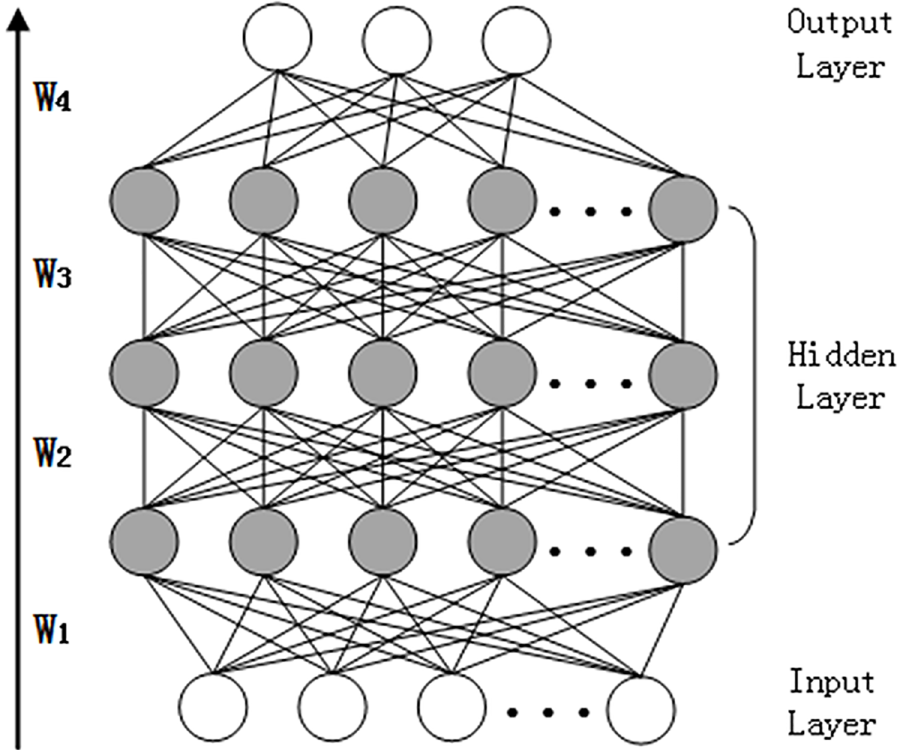
Fig 3. The topology of the SAE network. The representation ability of only auto-encoder is too limited. Thus the stacked auto-encodercomposed of multiple auto-encoder is able to greatly improve the representational power. The activationvalue of one auto-encoder is the input of the upper auto-encoder. It can be used as a pre-training techniqueand it should belongto the unsupervised learningmethod for it doesn’tneed label information at all. The topological graph of the SAE is shown in Fig